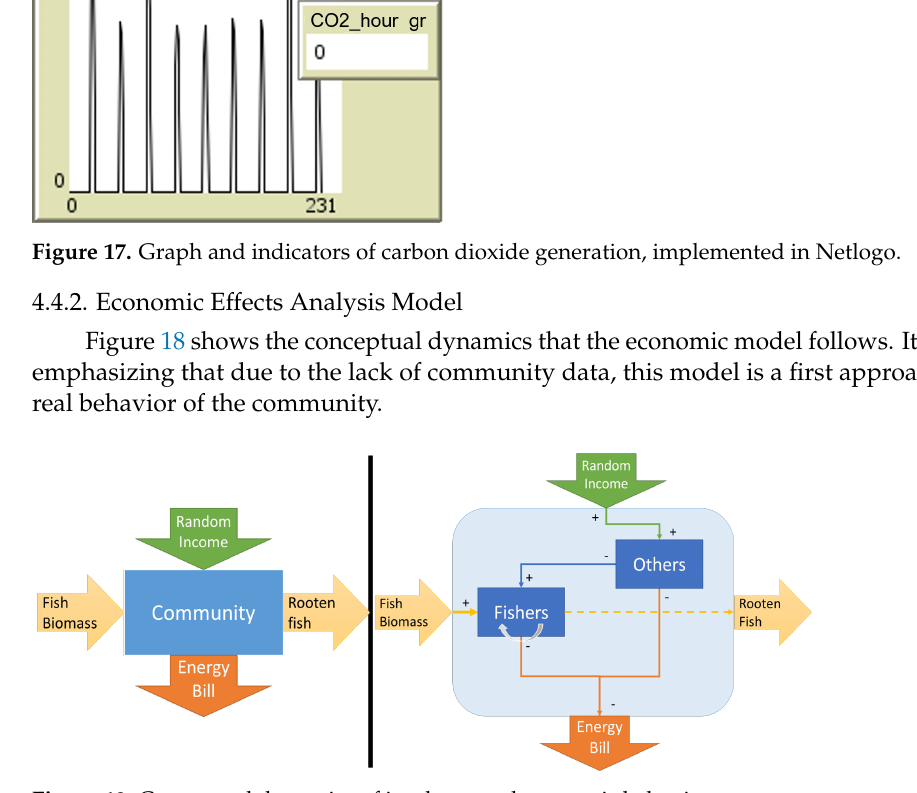
Figure 18. Conceptual dynamics of implemented economic